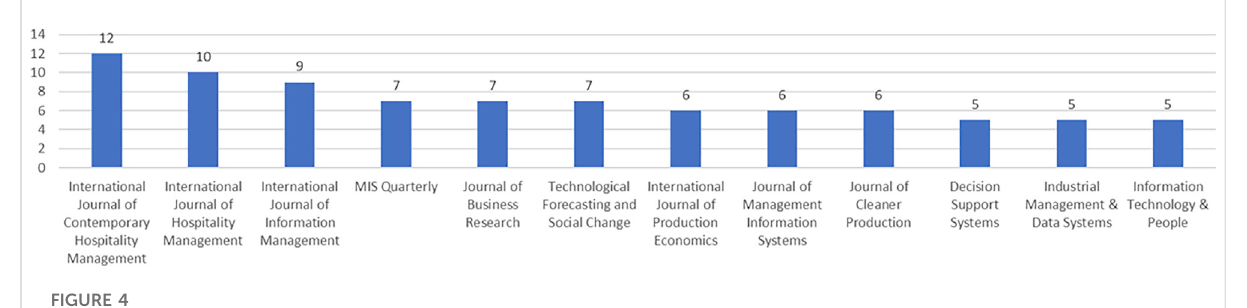
FIGURE 4 Number of articles published in top 11 journals.